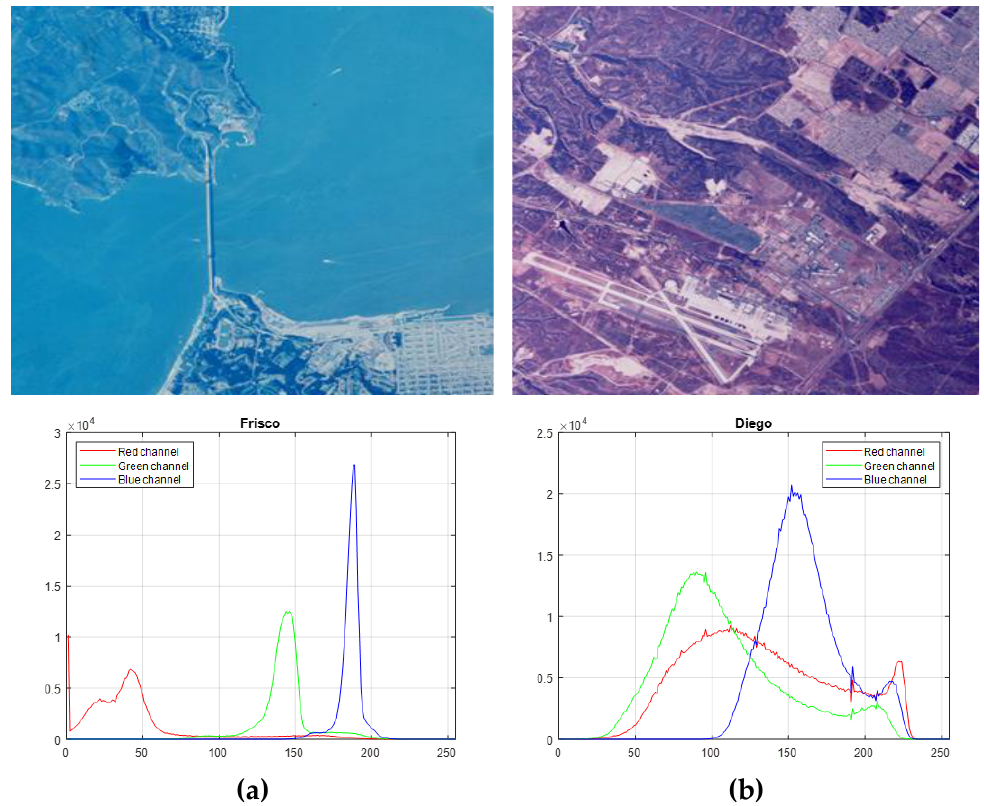
Figure 4. Additional color test images from the USC-SIPI database and their histograms: ( a ) Frisco (image no. 2.1.03); ( b ) Diego (image no.